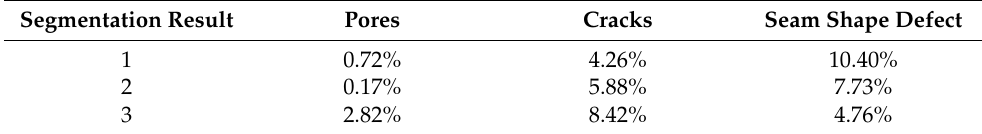
Table 11. Comparison of parsed results using the ratio of each defect in the weld